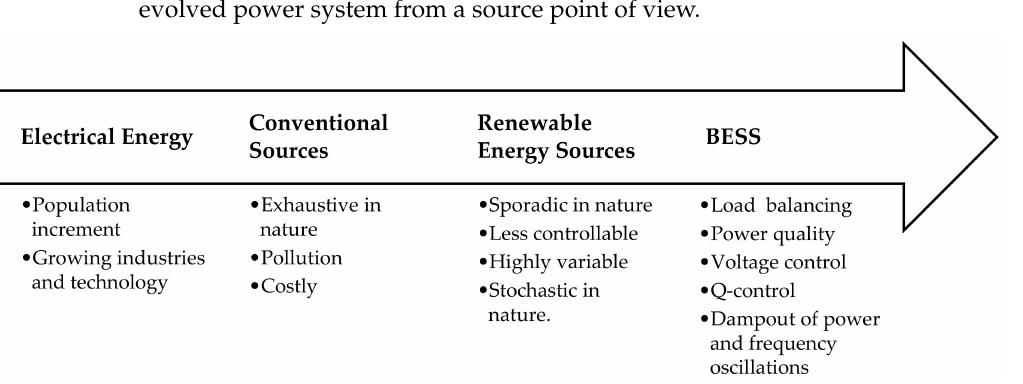
Figure 1. The evolution of power systems before DR